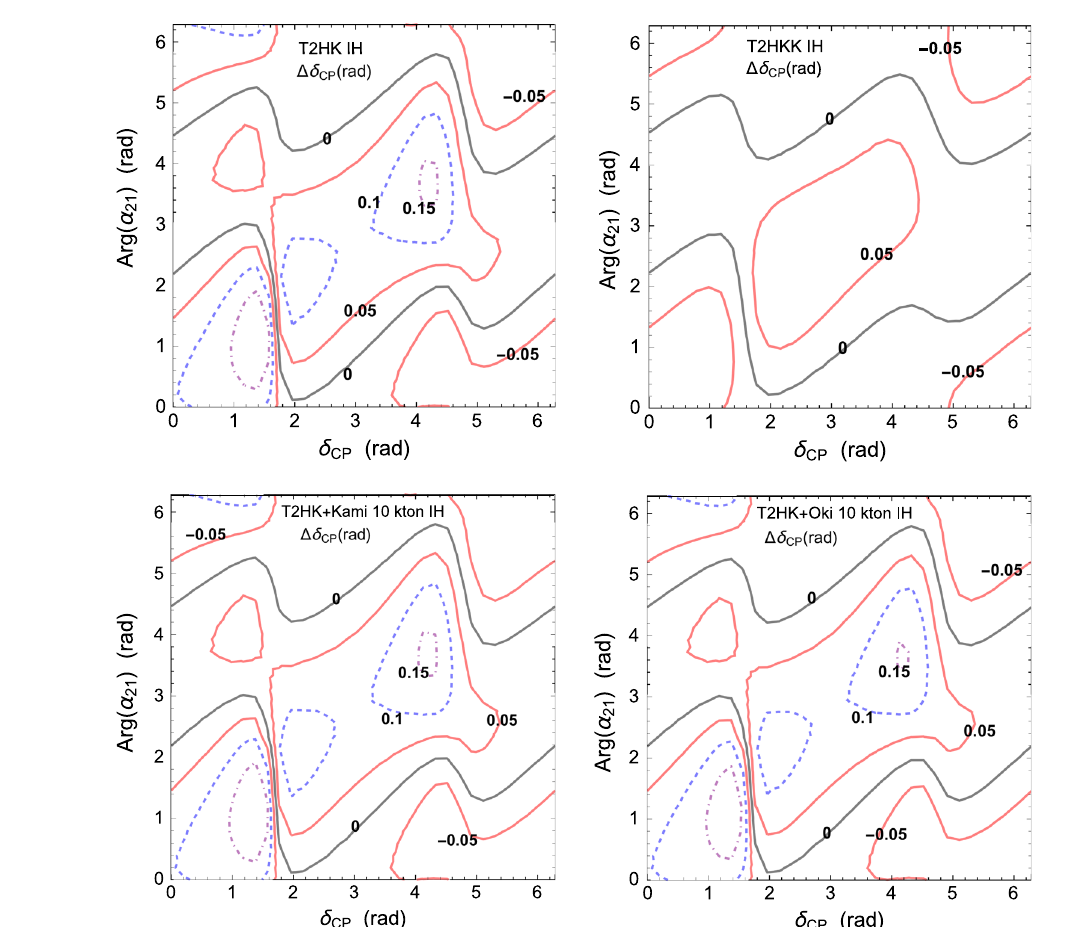
Cerenkov detector at Oki, respectively. For comparative study, we show in the lower-left a subplot for a plan of the T2HK plus a 10 kton water Cerenkov detector at Kamioka. | (cid:10)δ CP | = 0 , 0 . 05rad , 0 . 1rad, and 0 . 15rad on the black solid, red sold, blue dashed, and purple dot-dashed contours,